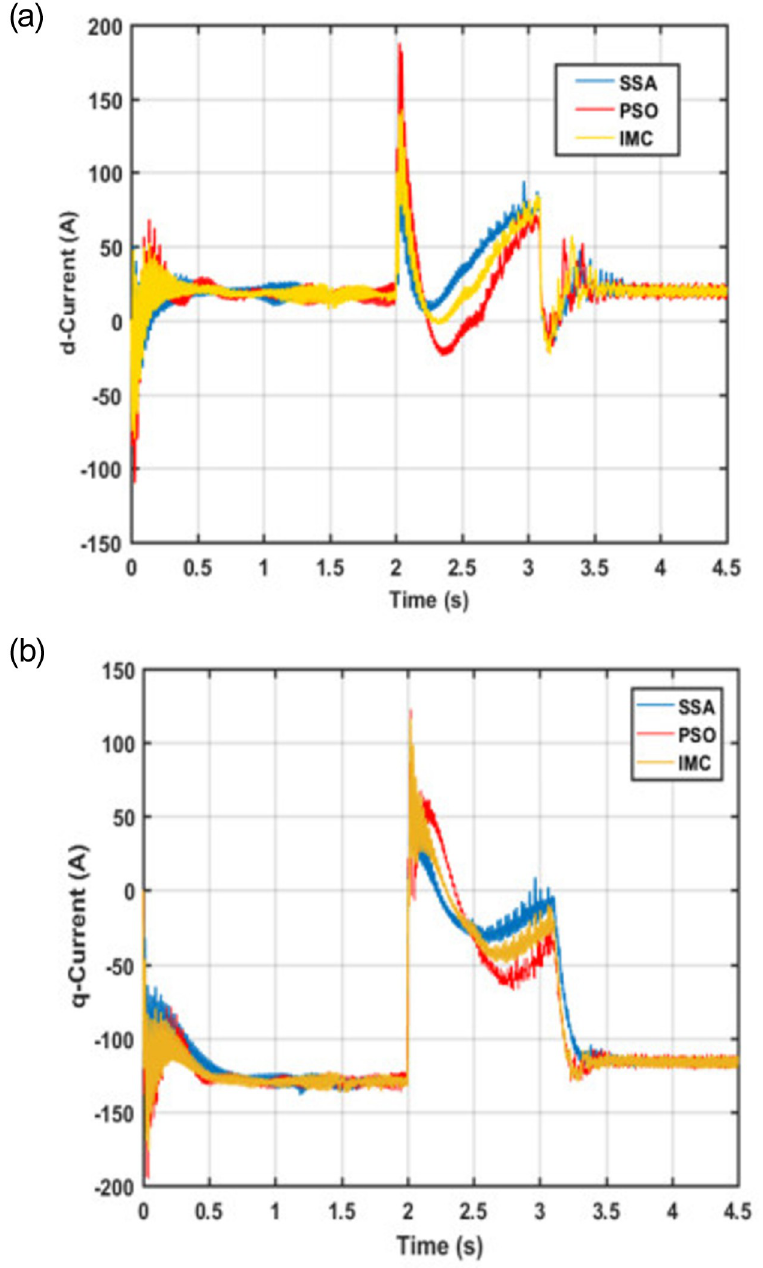
Fig 12. CW Current (a) d-component (b)